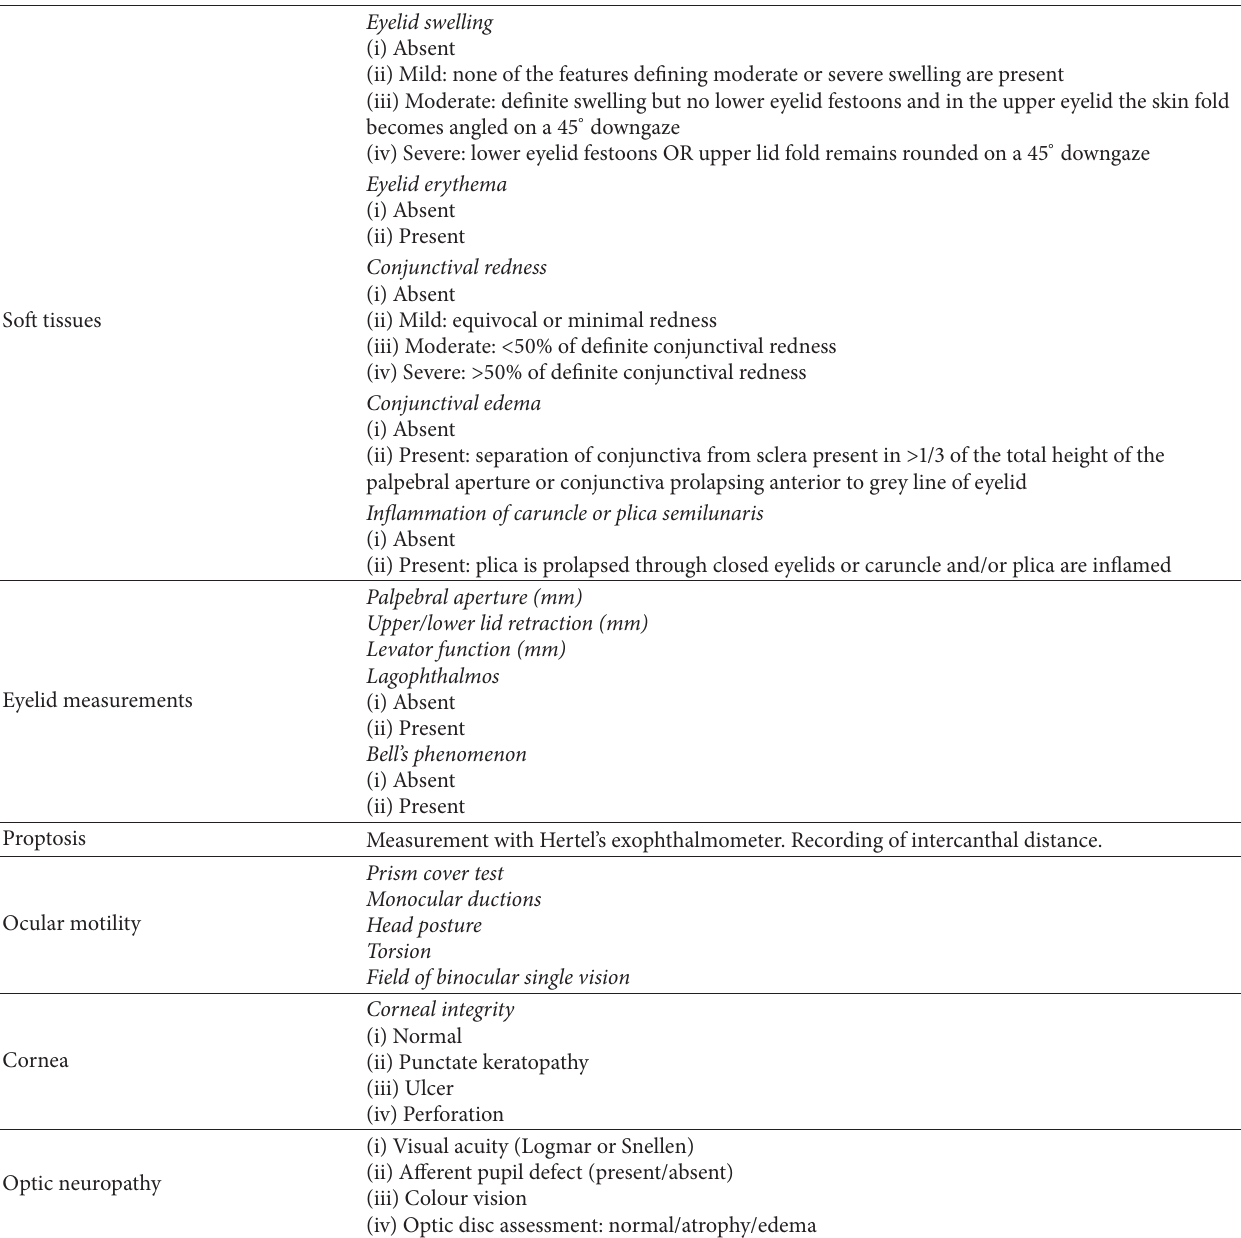
Table 4: Protocol to assess the severity of Graves’ ophthalmopathy (EUGOGO). Some of the signs may be assessed by comparison with the image atlas provided by the EUGOGO